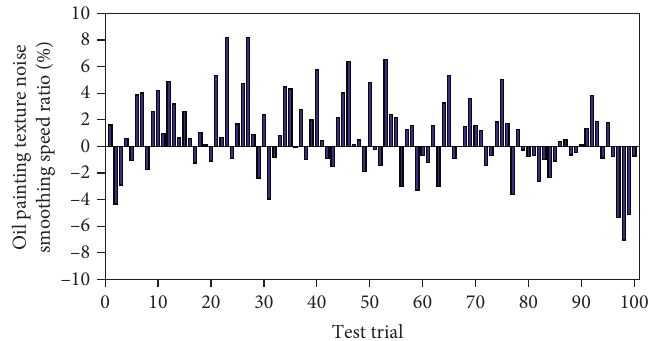
Figure 5: Oil painting texture noise smoothing speed ratio histogram.